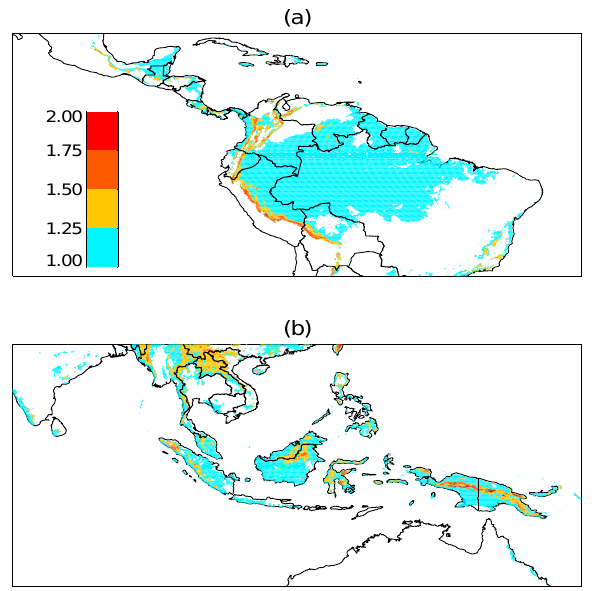
Figure 5. Impact of slope on the area of tropical forests. Colour shows the ratio of land surface area to planimetric area in (a) neotropics, (b)